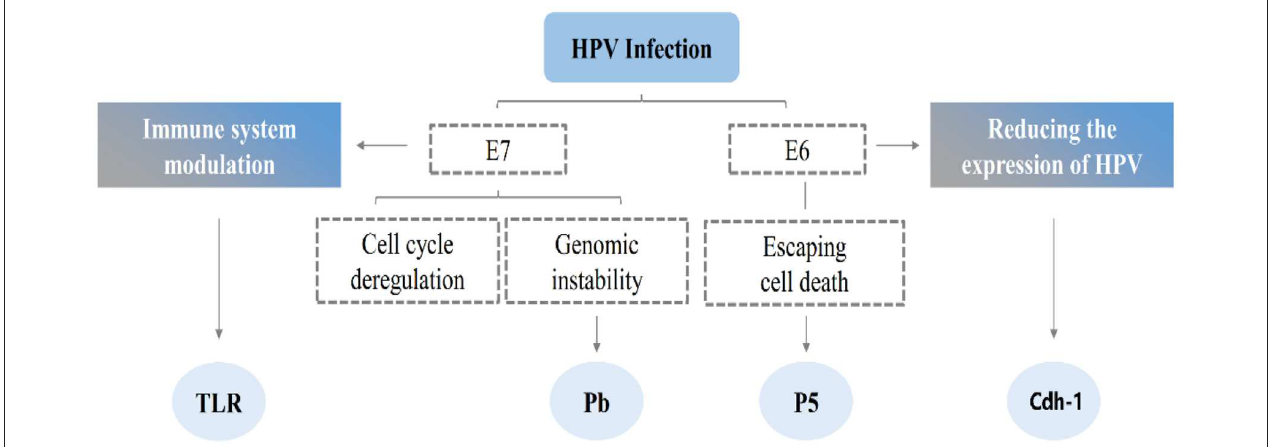
FIGURE 2 | The possible mechanism of HPV infection. Simultaneous molecular targets of the high-risk E6 and E7 oncoprotein. E6 and E7 are known to interact with a diverse range of molecules that are involved in several cellular pathways namely in immune system modulation, invasion, cell cycle deregulation. E6 and E7 share common targets that participate in important processes of cell invasion and inflammation, this cooperation may result in a synergistic mechanism, thereby promoting malignant cell transformation. HPV, human papillomavirus; INF, interferon; TLRs, toll-like receptors; Cdh-1, E-cadherin